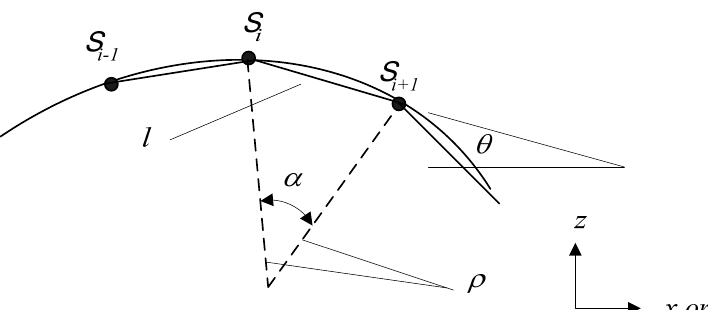
Figure 3. Geometry relationship between surface curve and microshaper path line segments.